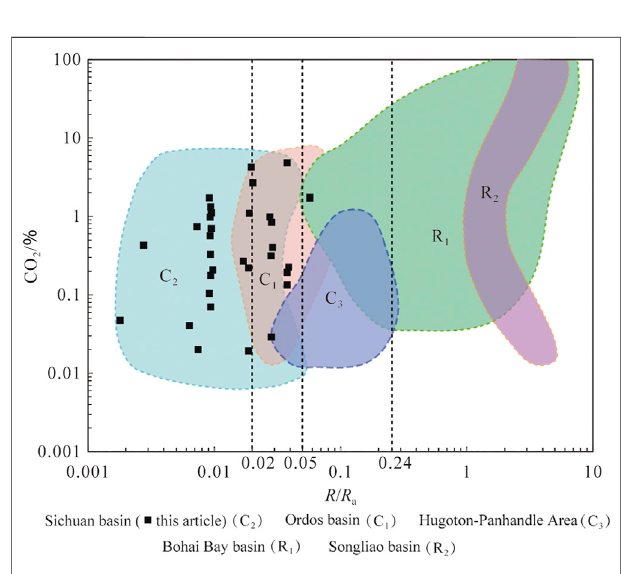
FIGURE 4 | Comparison of CO 2 -R/Ra between cratonic basin and rift basin (Modi fi ed after Dai et al., 2017).